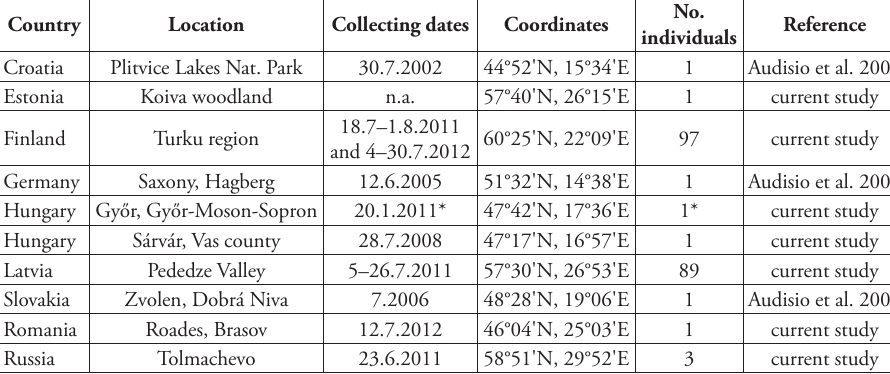
Table 1. Origin of sequence data used in this study (*reared individual). Sequenced specimens were collected from Central, Eastern and Northern Europe. The main part of the dataset ( N =193) consists of new sequences (GenBank accession codes: KY362552–KY362744), with additional material obtained from Audisio et al. (2009). Extended information of sampled individuals (e.g. GenBank accession codes) is provided in Suppl. material 1: Table